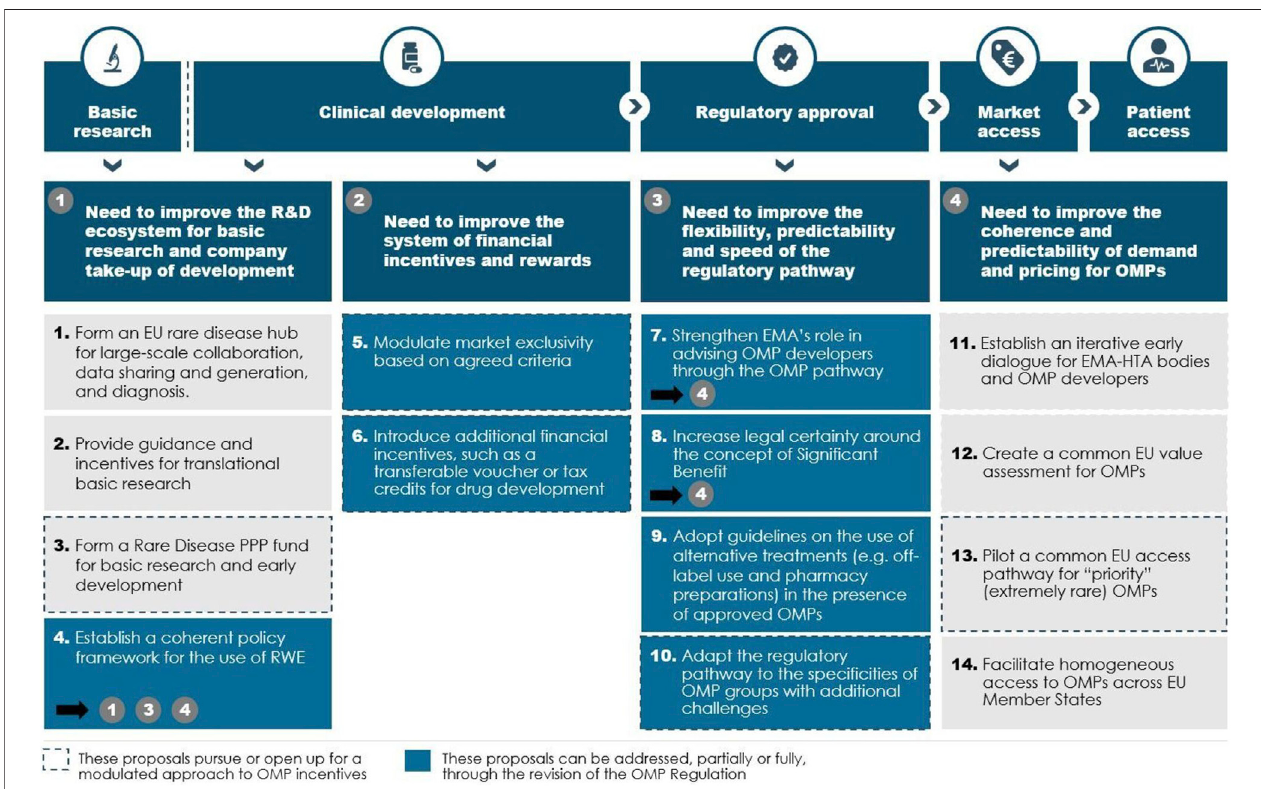
FIGURE 5 | Main needs and policy proposals. Source: The OD Expert Group